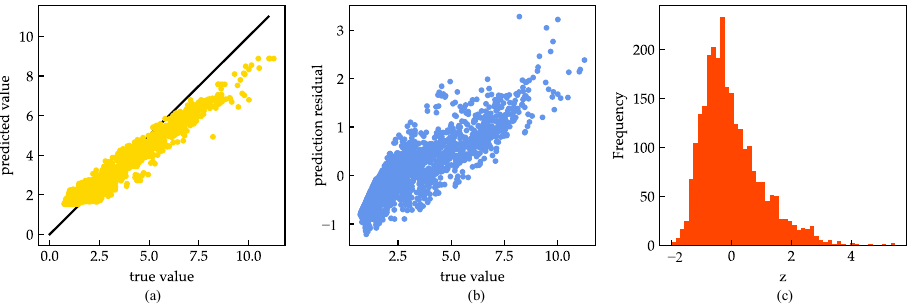
Figure 8. The prediction performance of LightGBM: ( a ) The scatter plot between predicted value and true value; ( b ) The scatter plot between prediction residual and true value; ( c ) The histogram of z in the model.